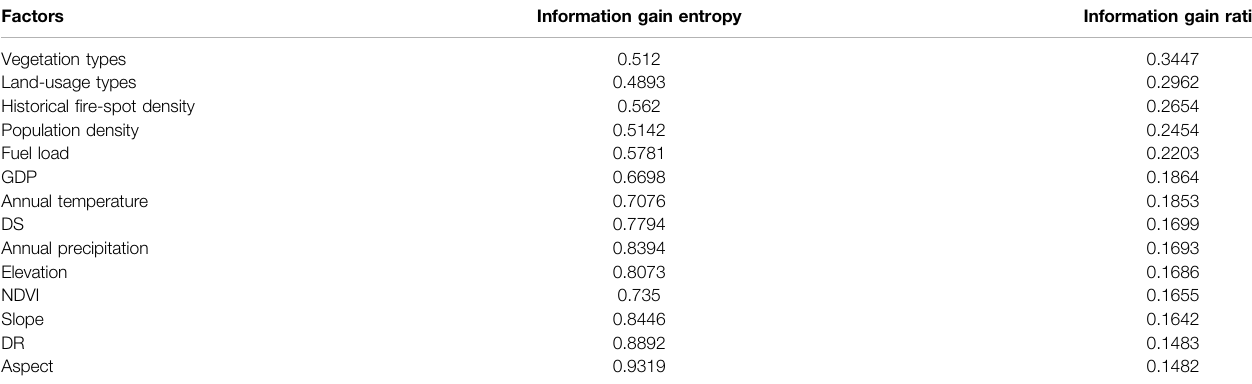
TABLE 1 | Importance of wild fi re-related factors.